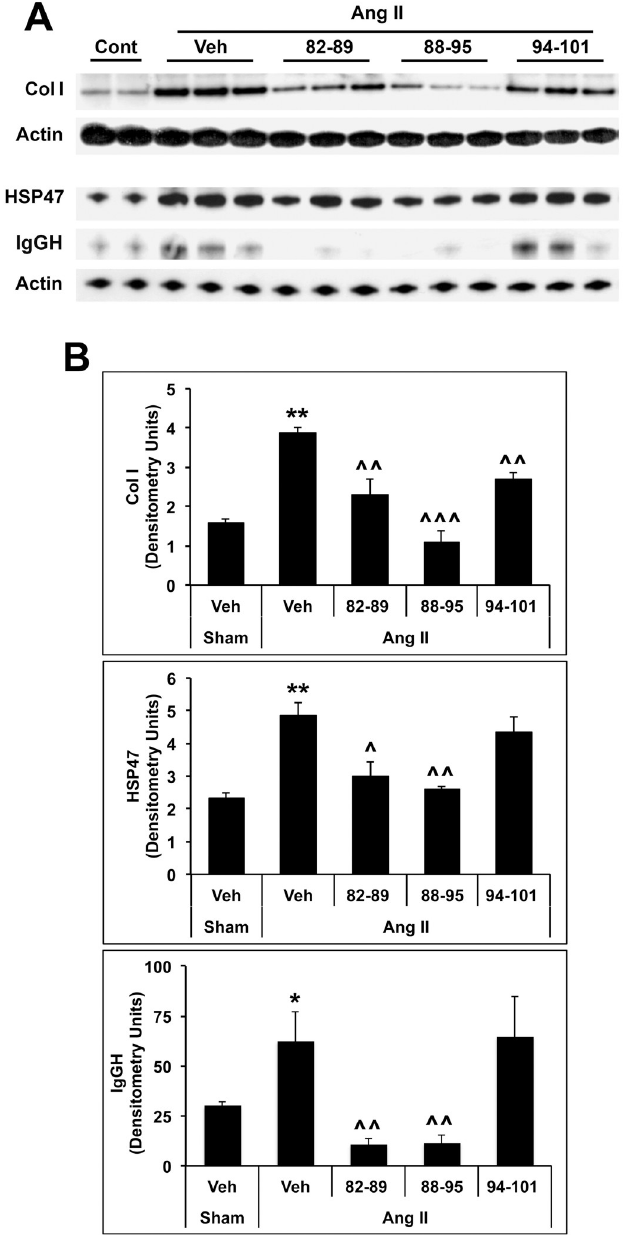
Fig 5. Inhibition of AngII-Induced fibrosis and microvascular leakage by CSD subregions. (A) HF induction and peptide treatment were as in Fig 4. Fibrosis was evaluated in LV tissue extracts by Western blot of Col I levels in the RIPA-insoluble fraction and HSP47 levels in the RIPA-soluble fraction. Microvascular leakage was evaluated in terms of IgG Heavy chain levels in the RIPA-soluble fraction. Actin in each fraction served as the loading control. n = 3 in this experiment. Similar results were obtained in a second experiment. (B) Quantification of Western blot results. Significant changes are shown as � p < 0.05 and �� p < 0.01 vs Sham control. Suppression of Ang II-induced changes by subregions are shown as ^p < 0.05, ^^p < 0.01, and ^^^p < 0.001 vs Ang II